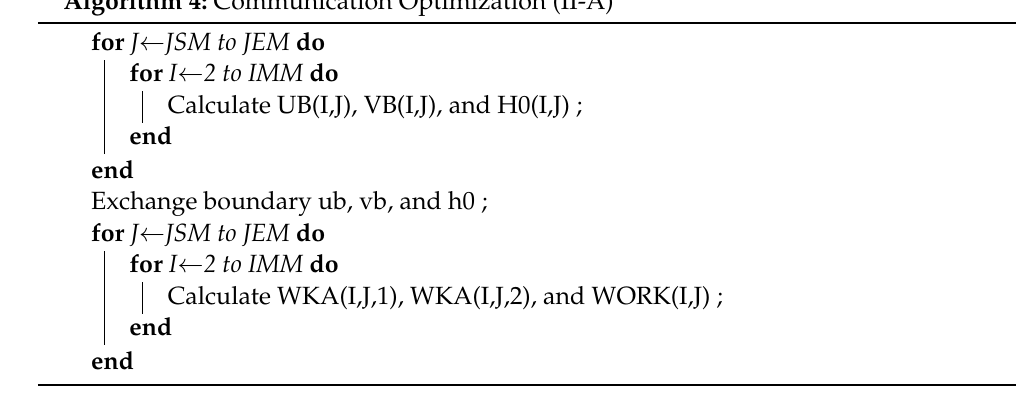
Algorithm 4: Communication Optimization (II-A)